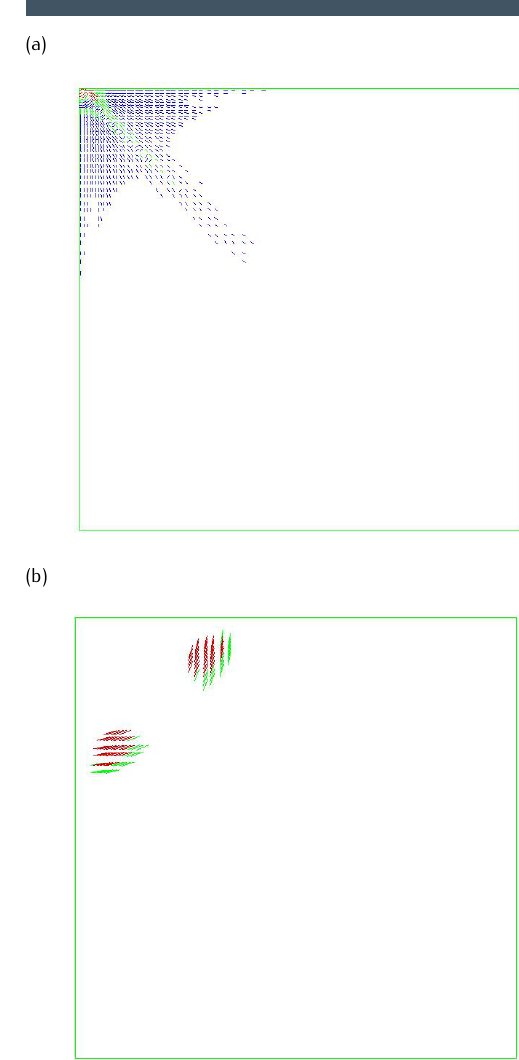
Figure 15. Centre load, (a) Vertical deformations [mm] at 380 kN; (b) Load-displacement curve.